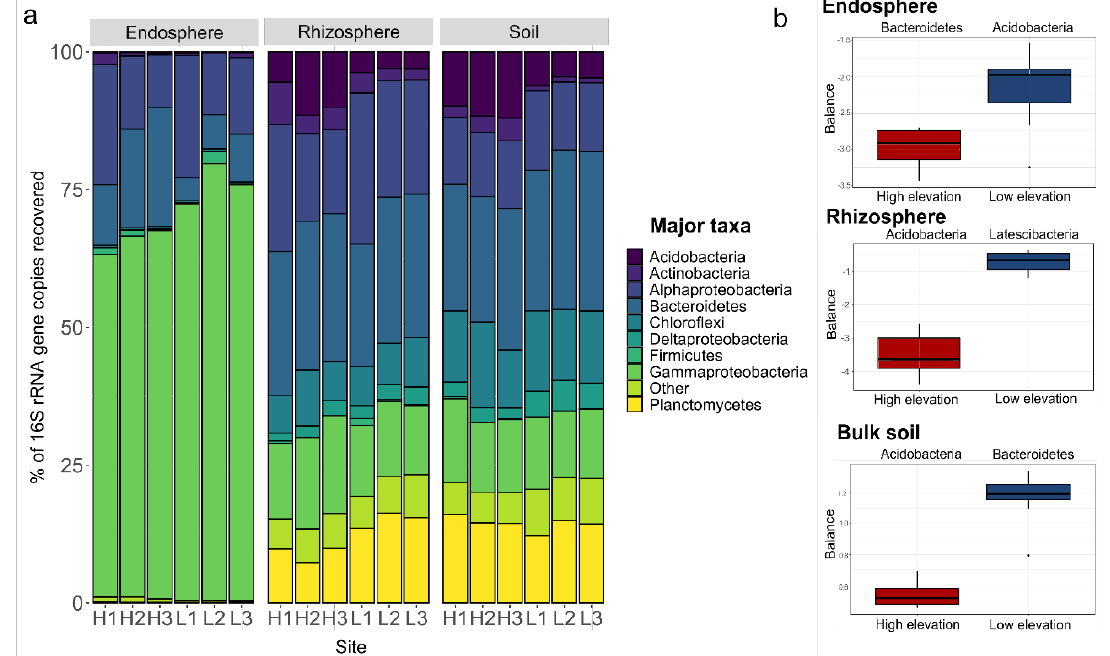
Figure 3. Relative ASV composition in Elytrigia atherica endosphere, rhizosphere and soil from each site at high salt marsh elevation (sites H1–H3) and low elevation (L1–L3). ( a ) Bar plot showing the phyla with at least 0.5% abundance, “Other” indicate the group of taxa with less than 0.5% abundance. ( b ) Phyla associated with either high or low elevation in each type of sample. Box plot shows root-mean-squared error resulted of the forward selection method. The apparent discrimination accuracy of these balances is 1.